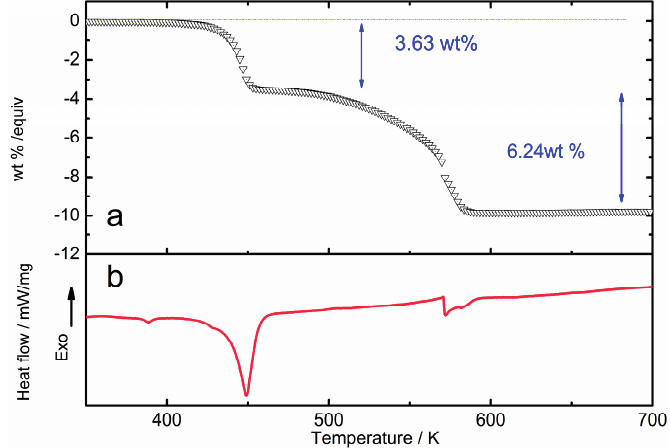
Figure 1. TG-DTA curves of 2Mg(NH 2 ) 2 –3LiH–LiBH 4 composite (T 2 ) ( a ) TG and ( b )